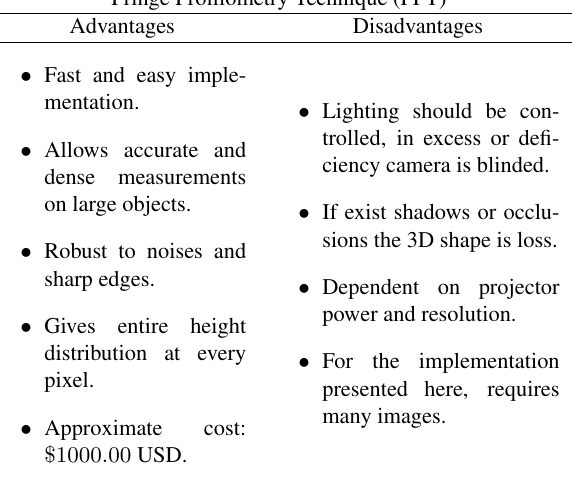
Passive Stereoscopy Technique (PST) Advantages